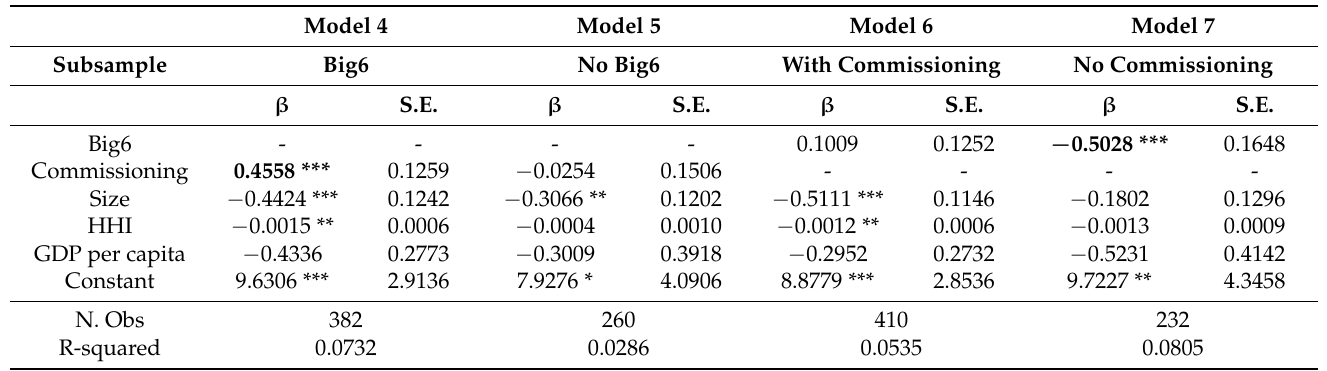
Table 5. Econometric results.